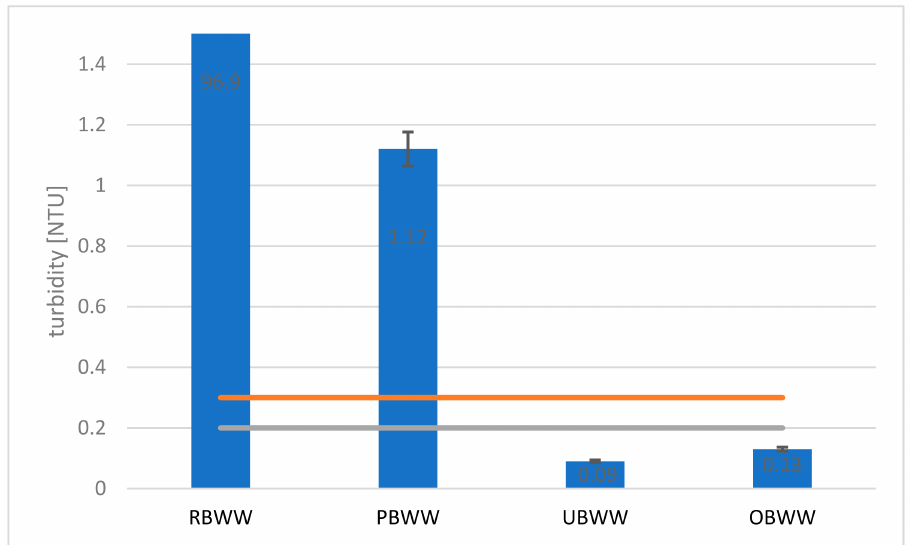
Figure 7. Changes in the turbidity values of backwash water after each process: raw backwash water (RBWW), pre-filter backwash water (PBWW), ultrafiltration backwash water (UBWW), ozonation backwash water